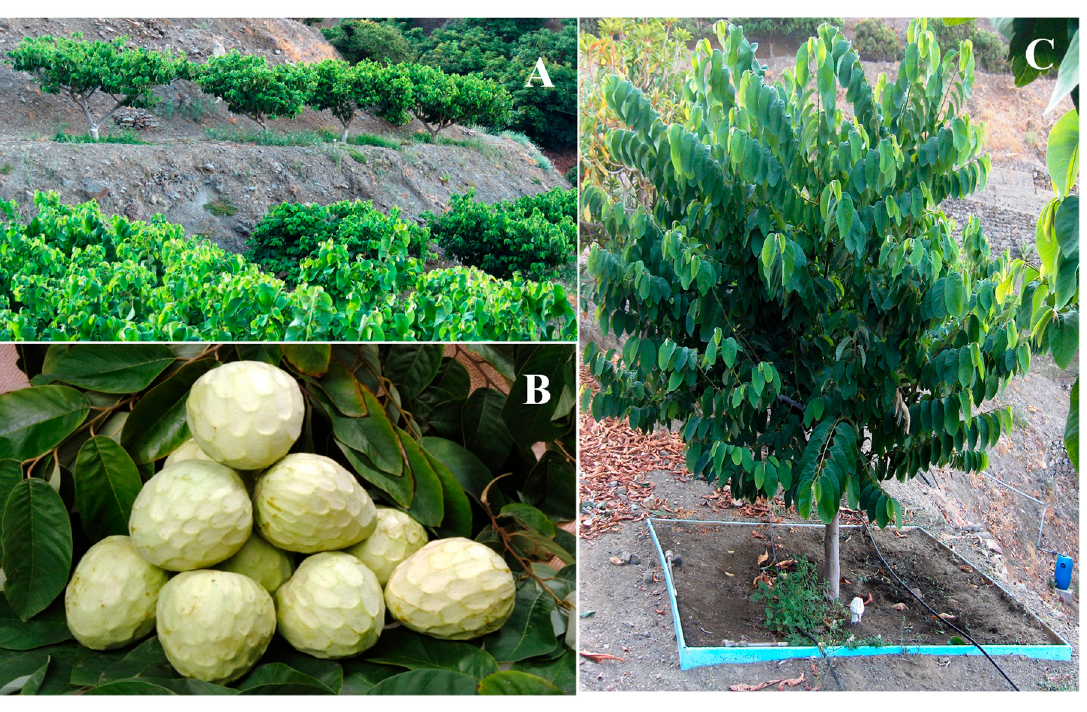
Figure 1. ( A ) Terraced cherimoya plantation, ( B ) cherimoya fruit Annona cherimola cv. Fino de Jete, and ( C ) drainage lysimeters used for the study.